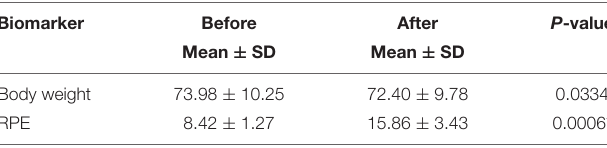
TABLE 3 | Body weight and subjective perception of effort of athletes in the pre- and post-competition periods ( n = 7).